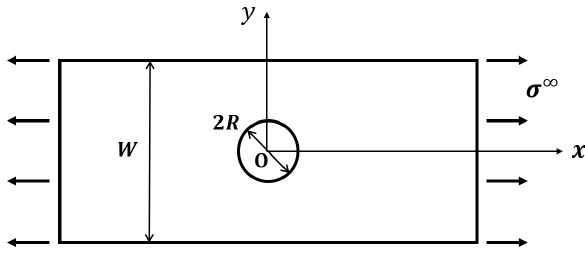
Figure 1. The model of a notched laminate under tensile